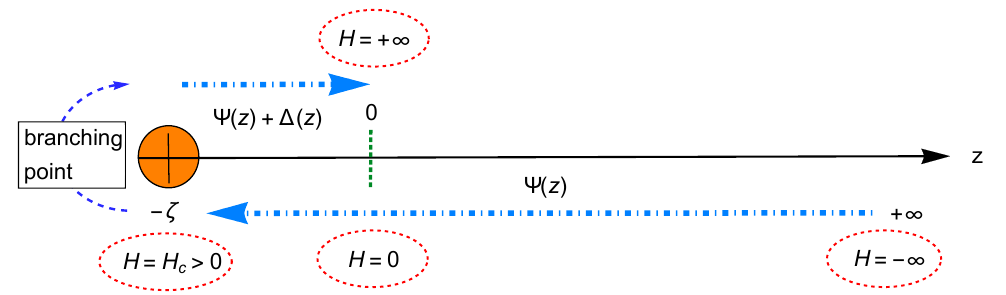
Figure 1: Schematic representation of the parametric solution of the optimization problem. For H ≤ H one uses the function Ψ in the parametric representation (40) c taking the parameter z to decrease from + ∞ to − ζ . At H = H to turn around the branching point and replace Ψ by its continuation Ψ + ∆ in (43) to determine all H ≥ H by increasing the parameter z from − ζ to c